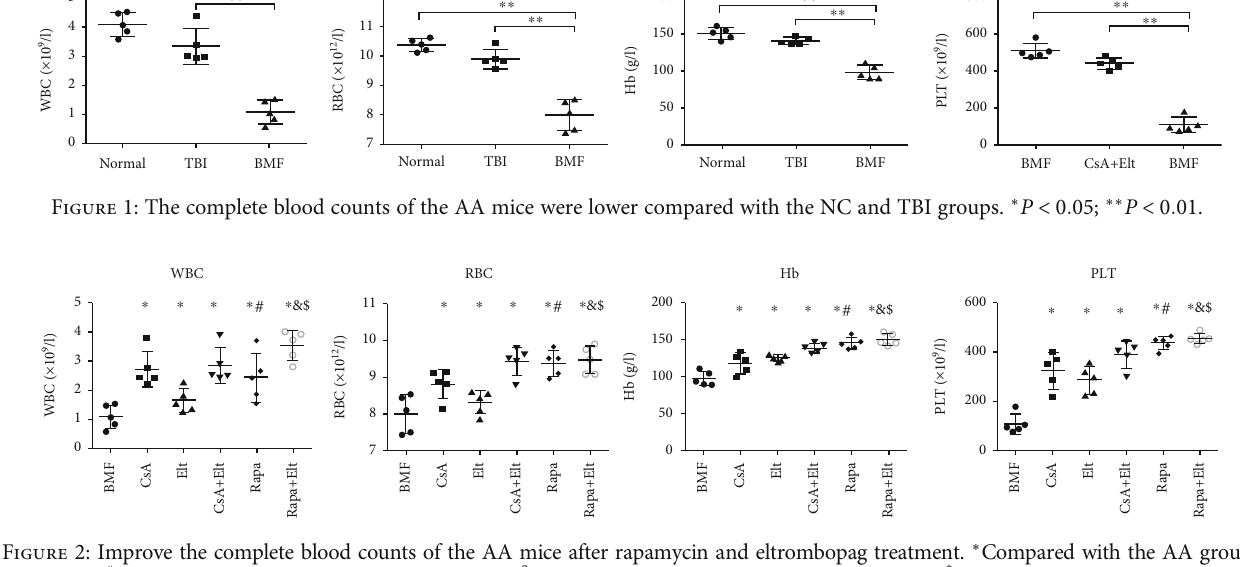
there is a potential synergy with immunosuppressant on AA mice to improve its outcome (Figure 5).